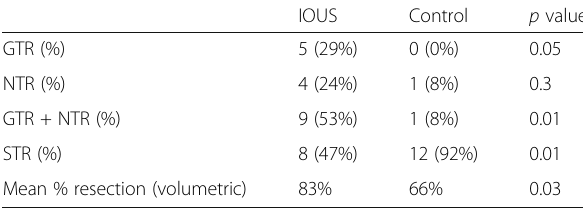
Table 3 Extent of tumor